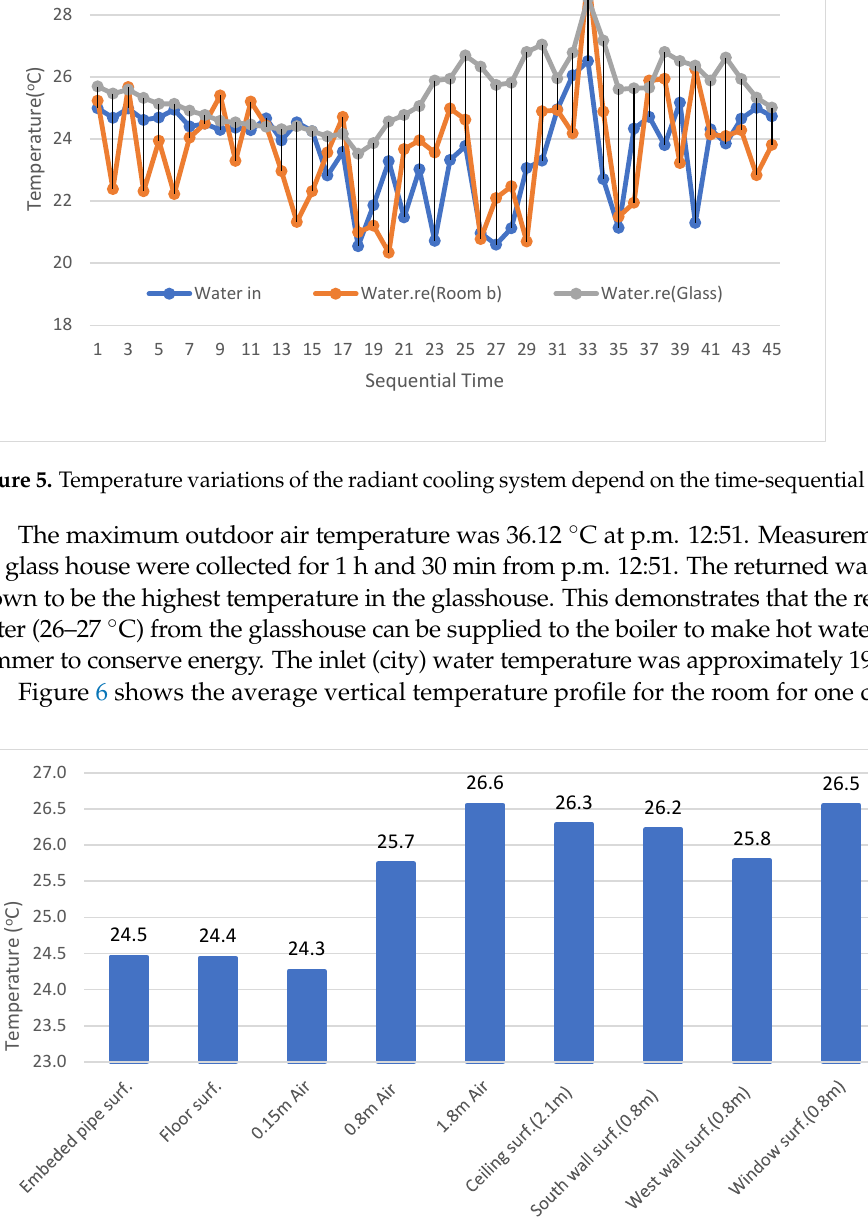
Measurement point(August 7, a.m.2:51-p.m.11:49) Figure 6. Vertical average temperature profile for the room for one day. The average outdoor air and glass house temperatures for one day are, respectively, 25.4 °C and 27.5 °C.